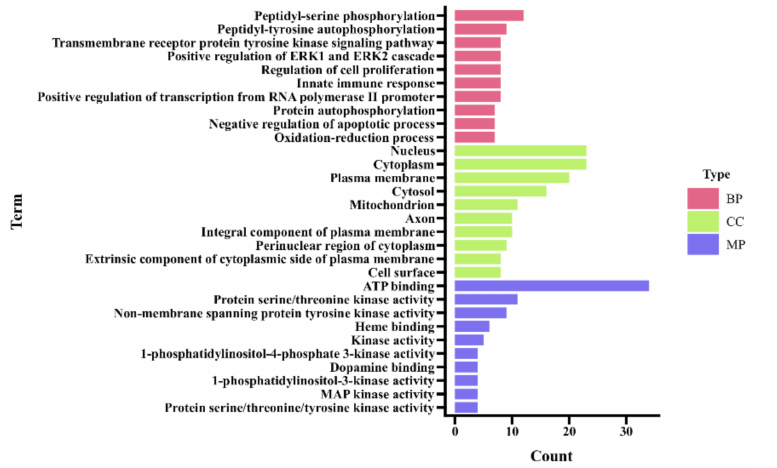
Figure 7. Gene Ontology (GO) enrichment analysis of the targets. (BP: biological processes, CC: cellular components, MF: molecular functions).